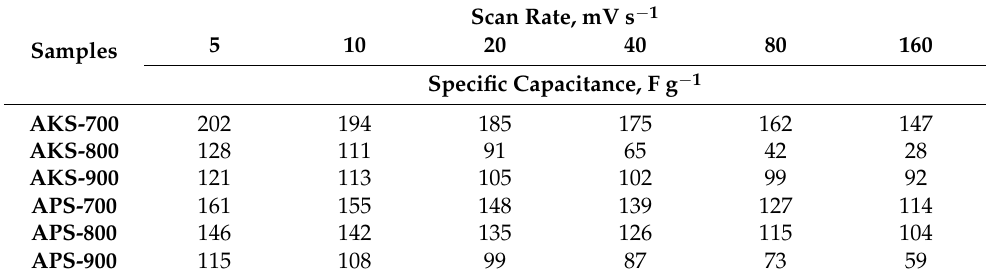
Table 3. The specific capacitance of AKS and APS obtained from CV data at different scan rates.